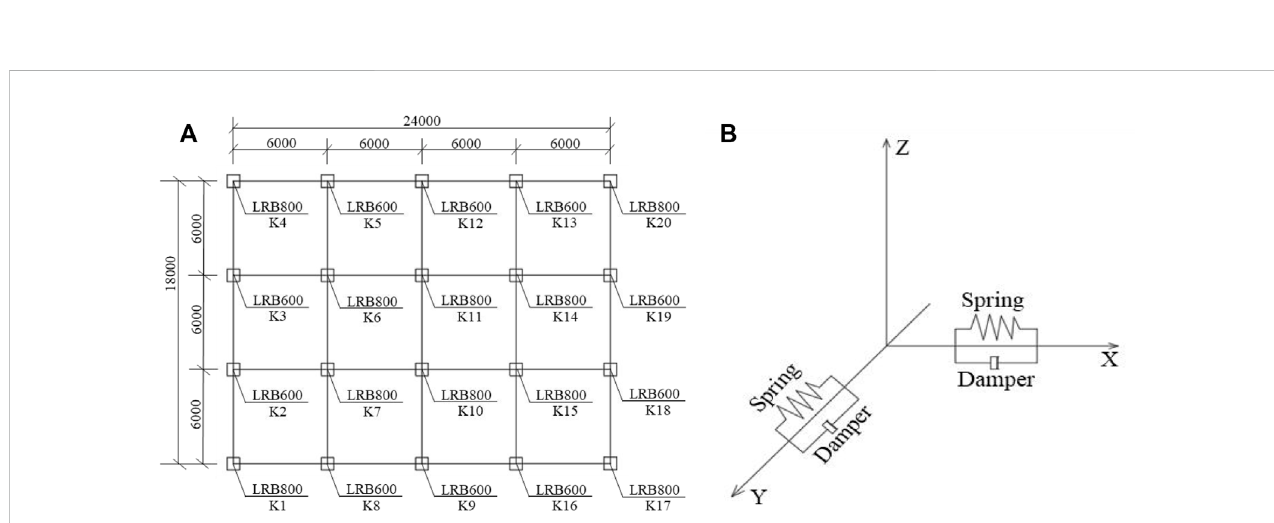
FIGURE 2 Isolated bearings. (A) Layout of isolated bearings. (B) Simpli fi ed mechanical model of the isolated bearing.